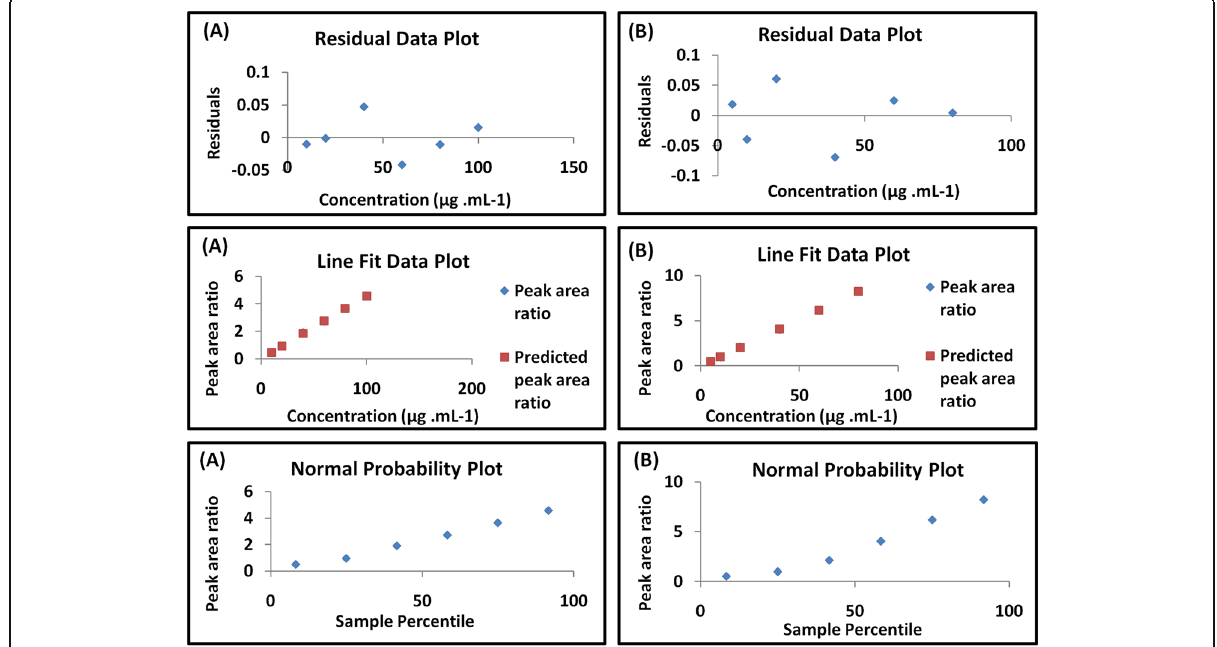
Fig. 6 Residual data plot, line fit data plot, and normal probability plot for SBR (a) and LPV (b) in RP HPLC-UV method